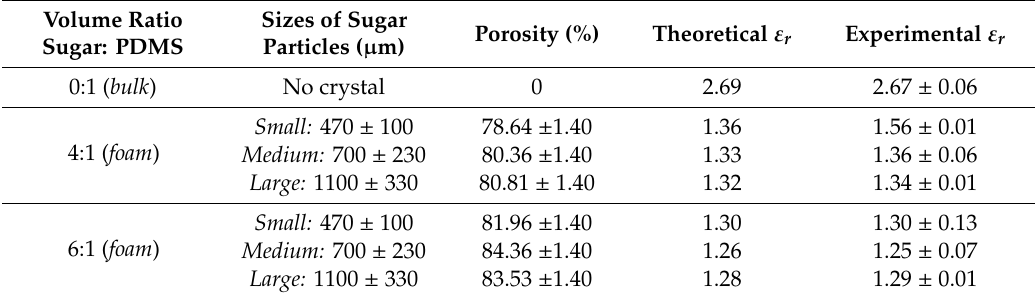
Table 1. Variation of the relative permittivity of the Microporous PDMS as a function of the